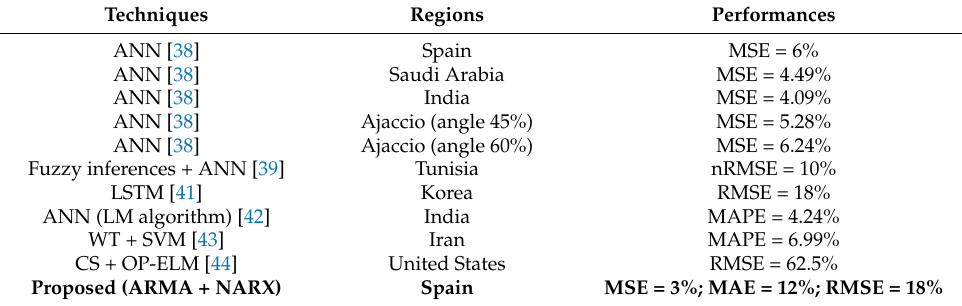
Table 16. Comparison between the proposed model and other research